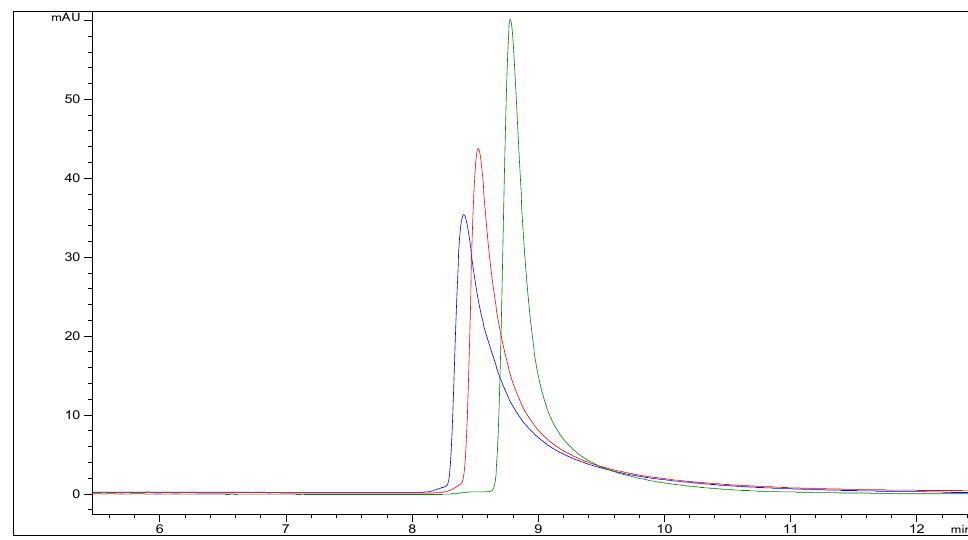
Figure A1. The effect of TFA concentration in the mobile phase on Lf peak shape: −− 0.03% TFA, −− 0.05% TFA, and −− 0.1% TFA. Separation was performed on Vydac ® Protein C4 #197 column at 30 ◦ C using TFA in water (A) and acetonitrile (B) as a mobile phase at a flow rate of 1.0 mL/min and the following gradient program: 0.0–10.0 min 20.0–60.0% B, 10.0–15.0 min 60.0% B, 15.0–16.0 min 60.0–20.0% B, 16.0–20.0 min 20% B.